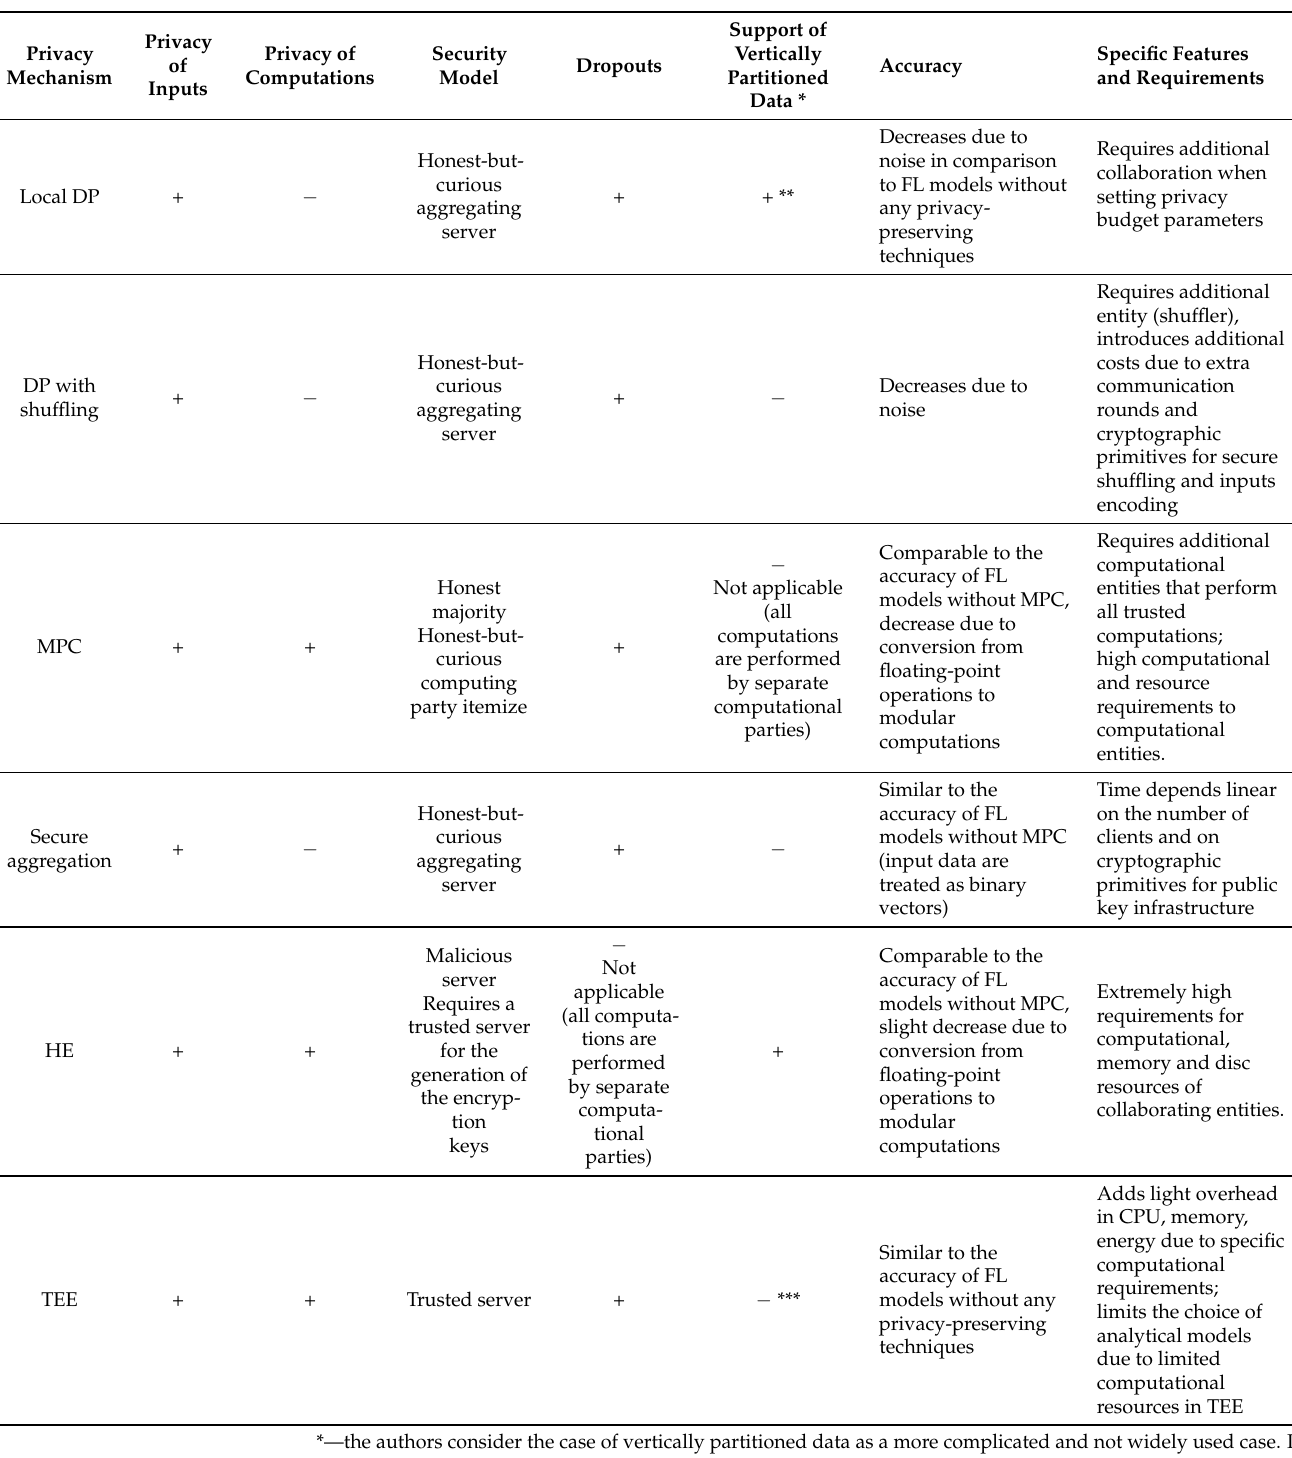
Table 1. Properties of privacy mechanisms adopted to FL